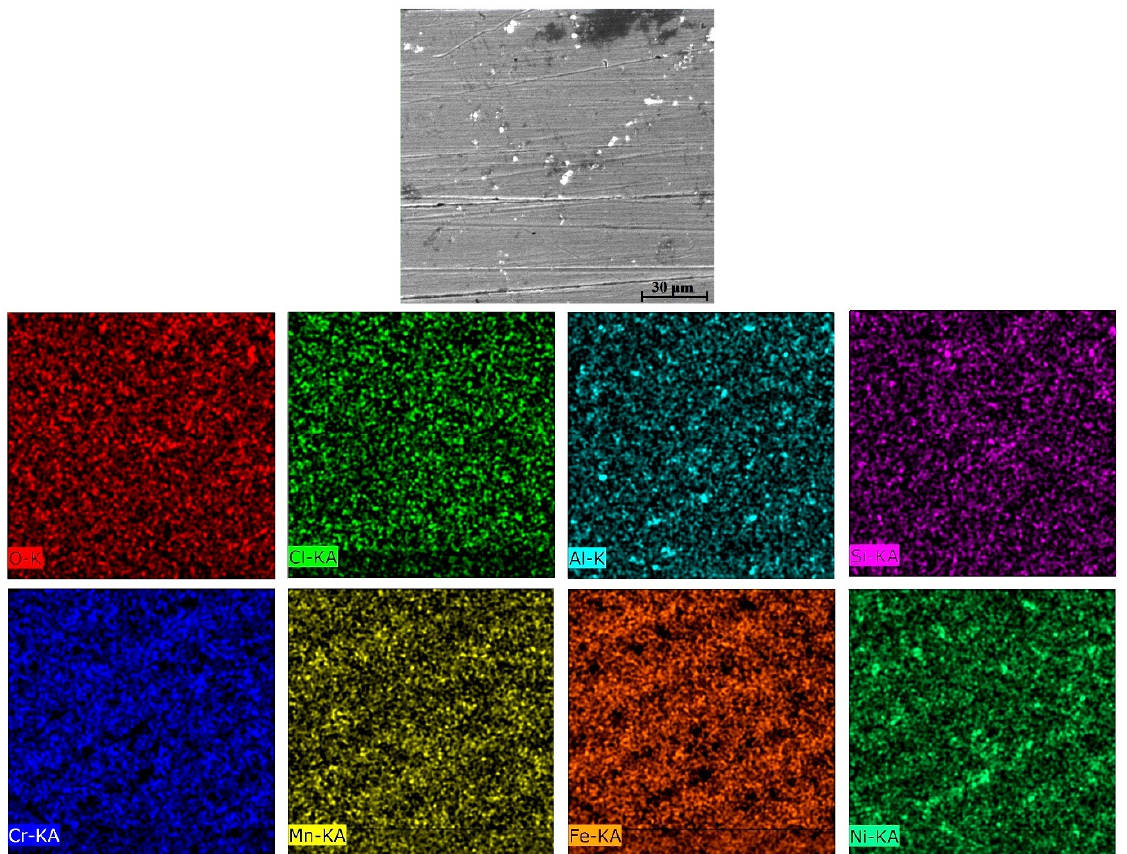
Figure 11. EDX elemental mapping of the corroded solution-treated Fe 36 Mn 20 Ni 20 Cr 16 Al 5 Si 3 HEA in 0.6 M NaCl.